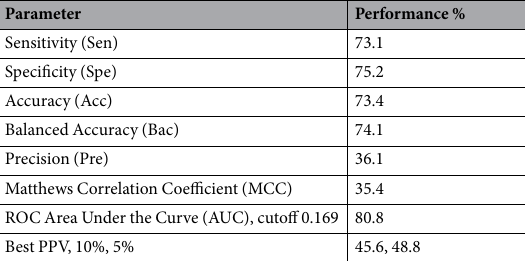
Table 1. Average of leave-one-out stratified cross-validation (27 sets) performance of EFoldMine based on the 30 proteins available in Start2Fold (see Supplementary section 1 for information on the performance